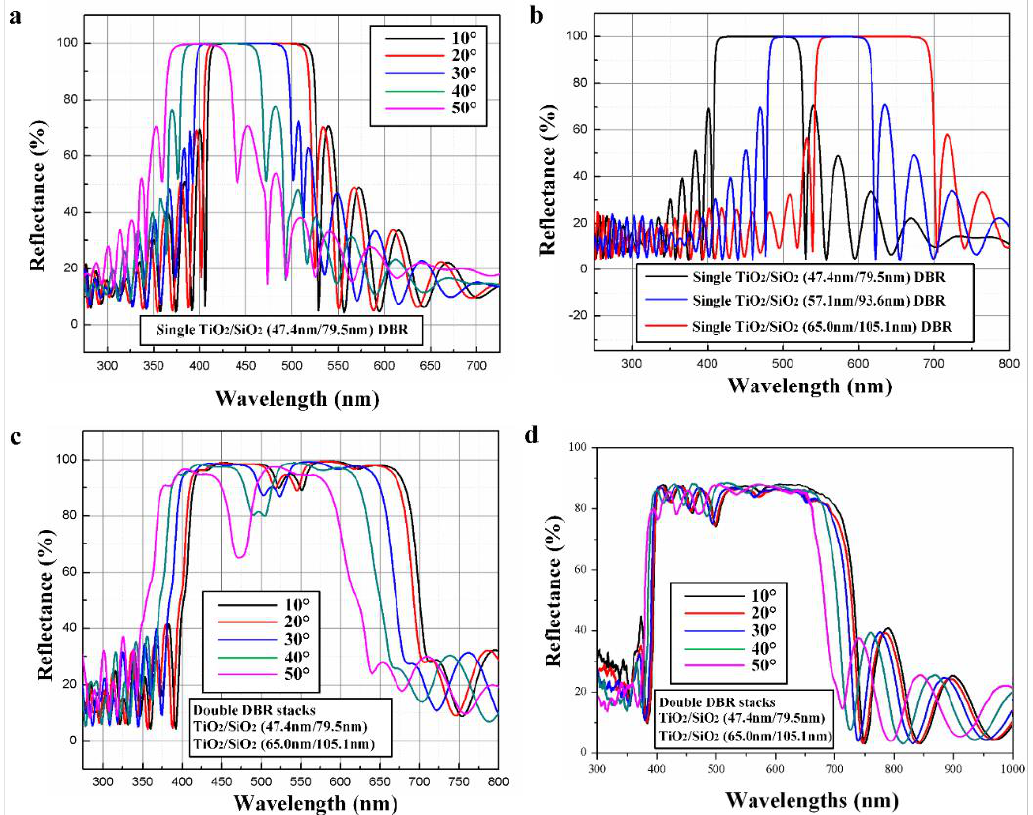
Figure 3. ( a ) Reflectance spectra of the single DBR stack as a function of incident angles of light. ( b ) Normal-incident reflectance spectra of the single TiO 2 /SiO 2 DBR stack optimized for a different central wavelength. ( c ) Reflectance spectra of the double DBR stacks as a function of incident angles of light. ( d ) Measured reflectance spectra of double DBR stacks.